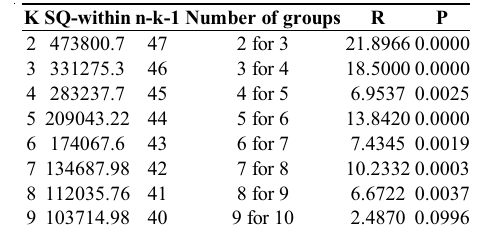
Table 1. Results used to calculate the R-statistic (R), to as- sess whether the increase from k to k+1 groups was signifi- cant. Sum of SQ-within = sum of sum of squares within; n-k- 1 = degrees of freedom; P = probability of Type 1